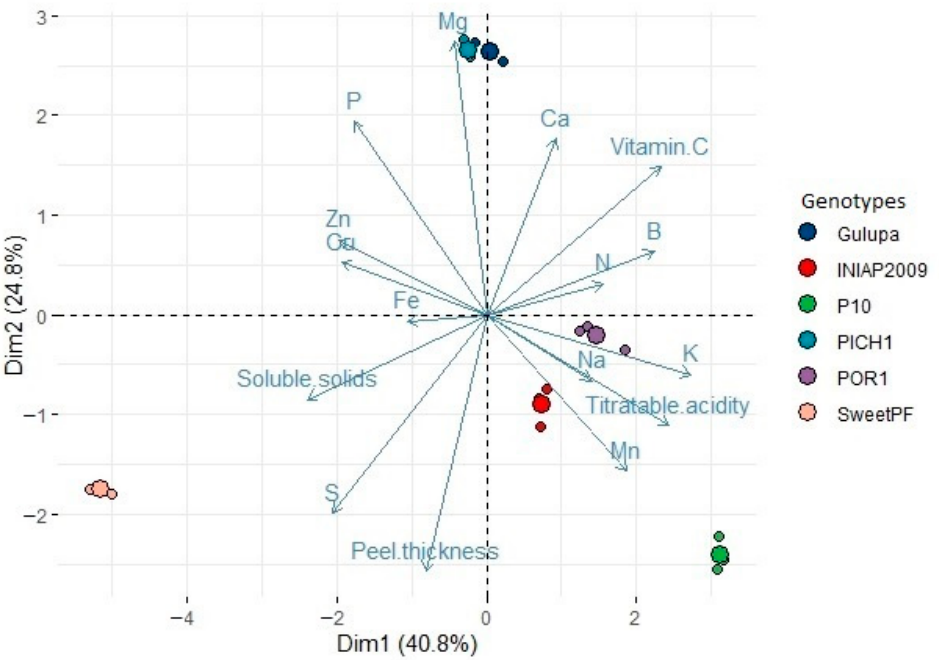
Figure 1. Principal component analysis for relevant fruit quality traits and mineral content of pas- sion fruit germplasm grown in